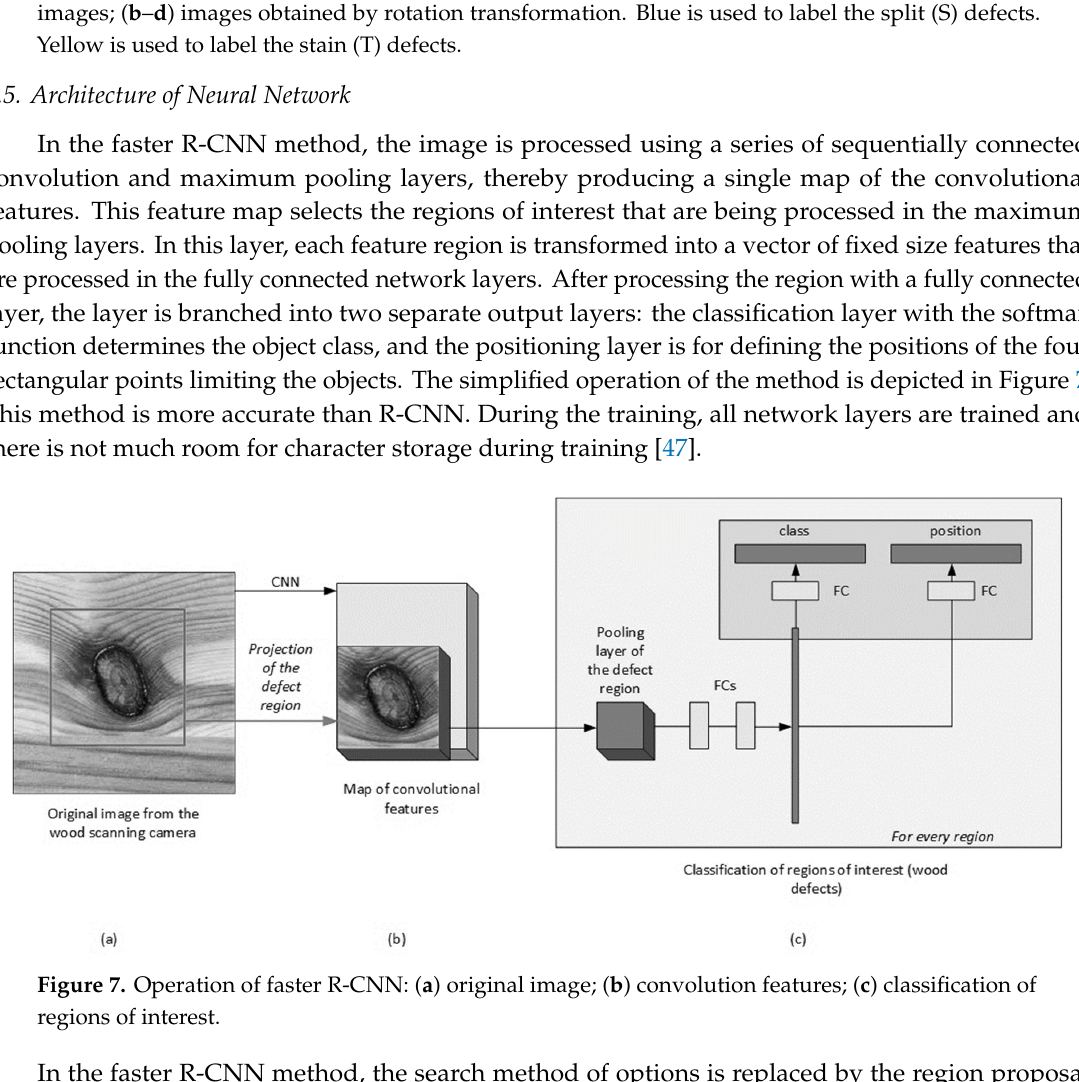
Figure 6. Example of data augmentation for increasing the number of images for training: ( a ) original images; ( b ‒ d ) images obtained by rotation transformation. Blue is used to label the split (S) defects. Yellow is used to label the stain (T) defects.